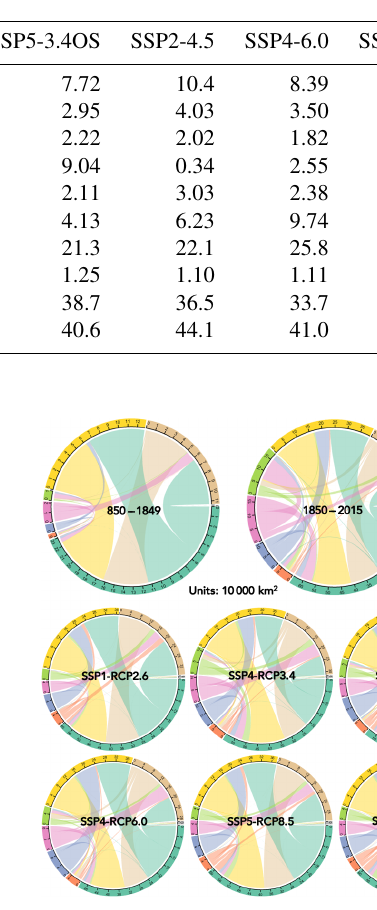
Table 4. Harmonized scenarios of future land use: global land use state areas in the year 2100 across all future scenarios (10 6 km 2 ).